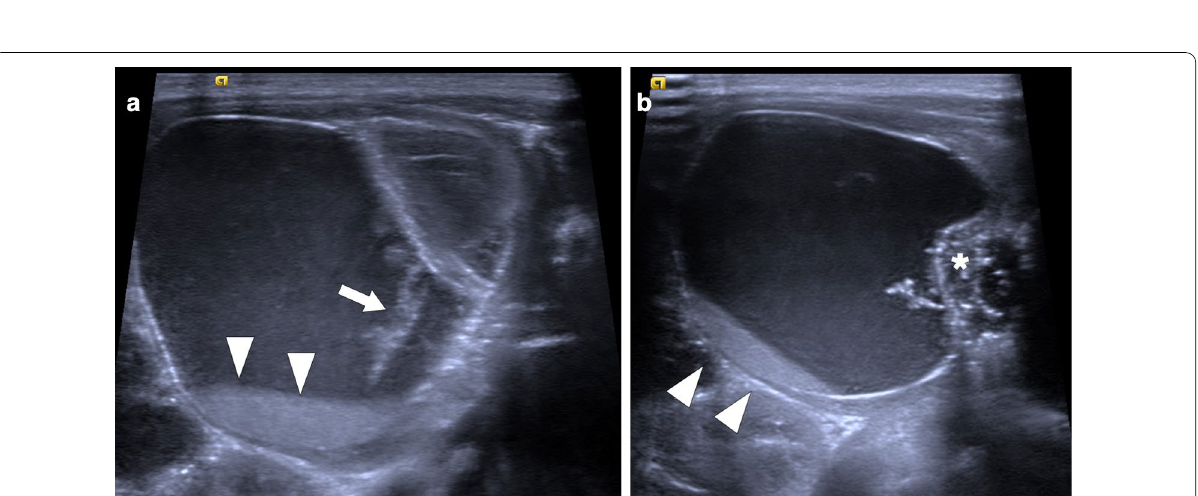
Fig. 31 Intrauterine ovarian torsion. 10-day-old newborn girl presented with a questionable abdominal mass detected by her parents. She was otherwise asymptomatic. Physical examination was unremarkable except for palpable pelvic mass. a , b Gray scale abdominal US images showed a right adnexal complex cystic mass containing internal echogenic debris (arrowheads). The lesion was mostly cystic with irregularly thickened walls, internal septations (arrow), and a solid component with scattered calcifications (asterisk). Surgical resection and subsequent histopathological examination revealed cystic lesions with internal hemorrhage. The thick walls of the lesion were found to be non-neoplastic and composed of widespread fibrosis, necrosis and dystrophic calcifications. Findings were considered consistent with in utero ovarian torsion. Her recovery